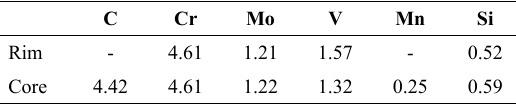
Tensile rods sintered at high temperatures, e.g. above 1350 °C, have been geometrically distorted during sintering preventing thereby accurate mechanical measurements. Sintering at lower temperatures resulted in a